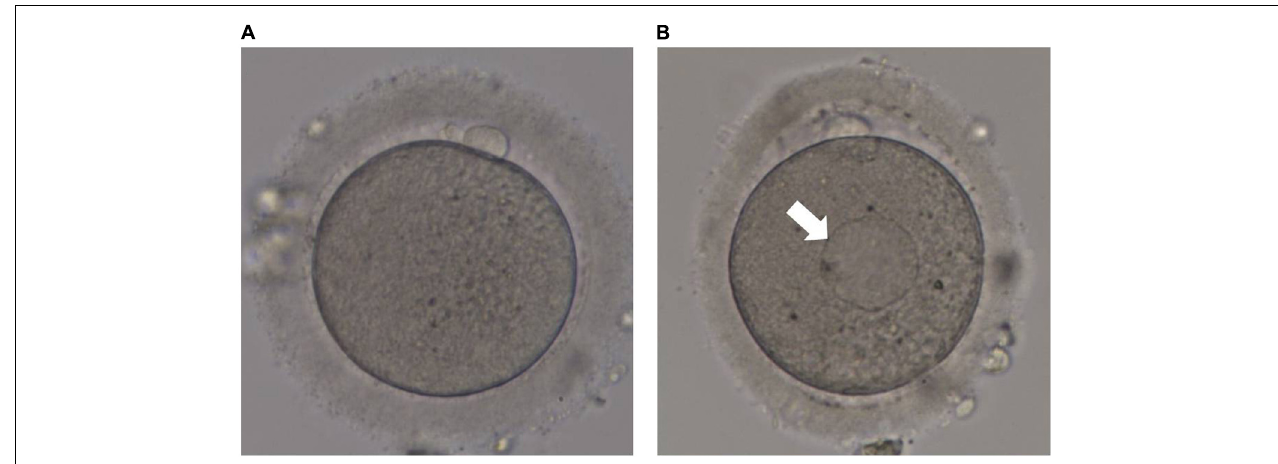
FIGURE 2 | Human metaphase II oocytes as viewed by light microscopy. (A) Normal metaphase II oocyte; (B) metaphase II oocyte containing a smooth endoplasmic reticulum cluster